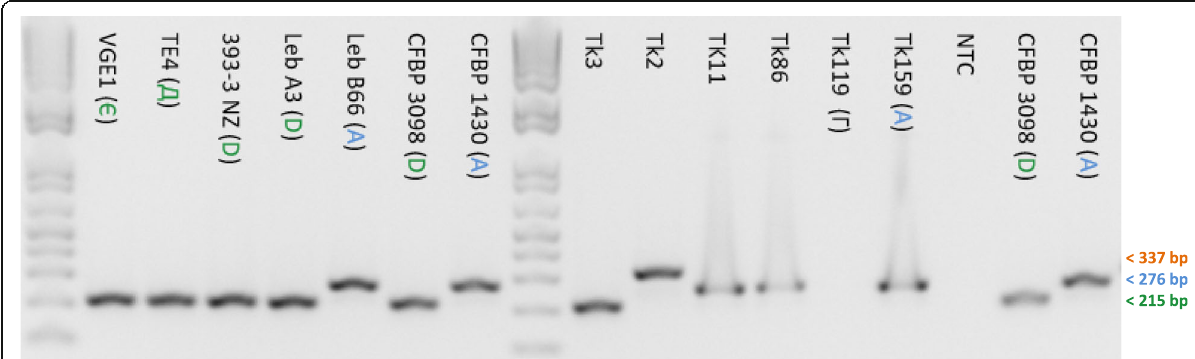
Fig. 2 PCR amplification of the genomic region containing spacer 1029 in different strains of E. amylovora using primers C1f04 and C1r09. Strains bearing two copies of spacer 1029 (A-derived genotype, blue) yielded a 276 bp amplicon, while those bearing a single copy (D-derived genotype, green) resulted in a shorter band at 215 bp. Strain Tk119, which displays an extensive deletion at the 5 ′ end of the array that includes both primer annealing sites, did not yield (as expected) any amplification. One of the four additional Turkish isolates with unknown genotypes tested (Tk3) revealed a D-derived genotype, while two others (Tk11 and Tk86) could be assigned to the A-derived genotype. A fourth isolate (Tk2) displayed a larger band on gel that indicates the generation of a longer PCR product. Sanger sequencing of the purified 337-bp amplicon revealed the presence of a third copy of spacer 1029, a result that is compatible with the estimated size of the band on gel. CFBP 3098 and CFBP 1430 were used as positive controls for D- and A-derived genotypes, respectively. PCR-grade water was used as the negative non-template control